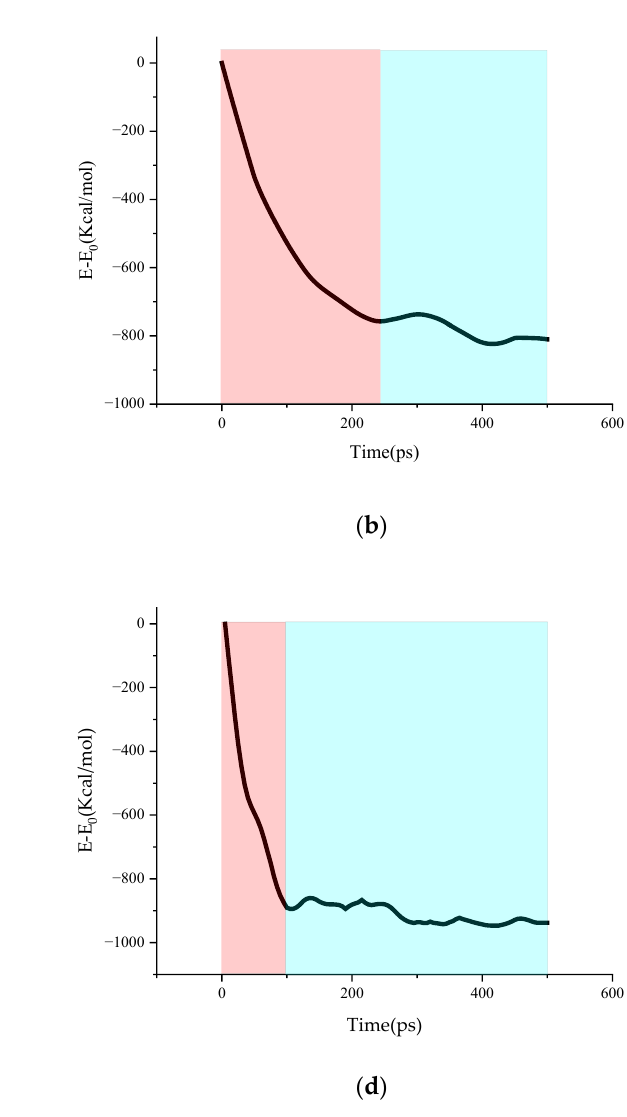
Figure 16. Van der Waals energy change during asphalt binder healing at different damage levels: ( a ) 100% damage; ( b ) 75% damage; ( c ) 50% damage; ( d ) 25% damage (The red area is the curve A area, the cyan area is the curve B area). Table 4. Energy values for different damage